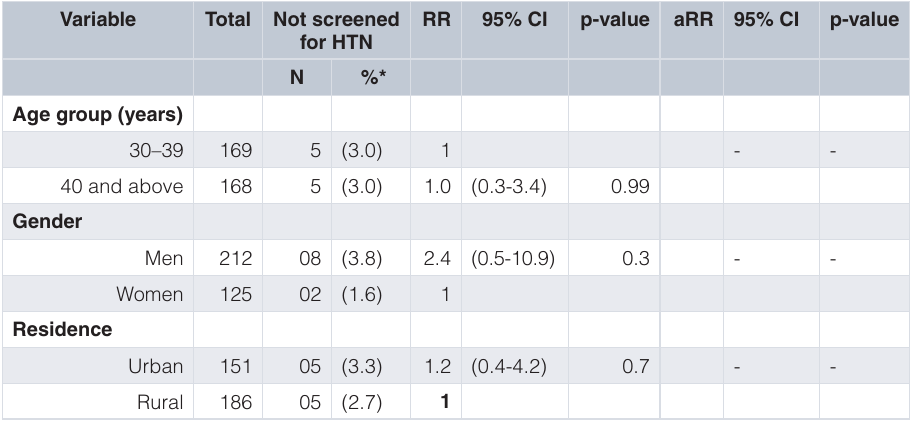
Table 4. Association of socio-demographic characteristics with not being screened for hypertension (HTN) among eligible population seeking care at the outpatient department in the two selected primary healthcare centres from March to May, 2019